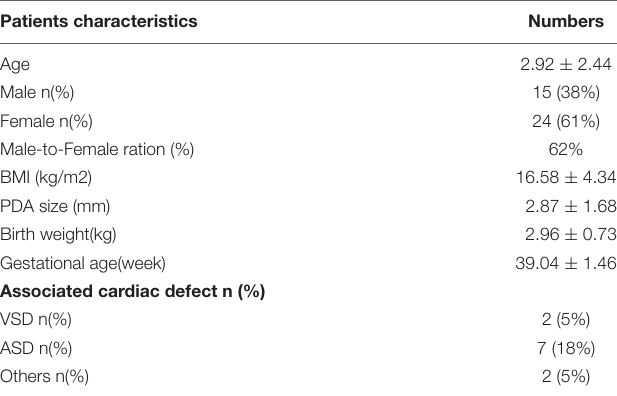
TABLE 1 | Characteristics of 39 PDA